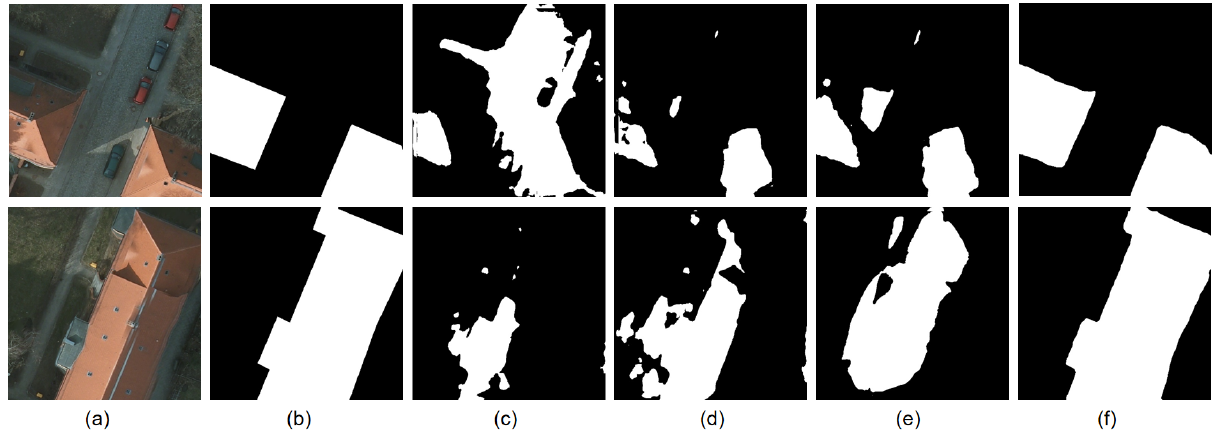
Figure 12. Segmentation results in Vaihingen → Potsdam experiment. White and black pixels represent buildings and background. ( a ) Potsdam. ( b ) Label. ( c ) DeeplabV3+. ( d ) Color matching. ( e ) CycleGAN. ( f )